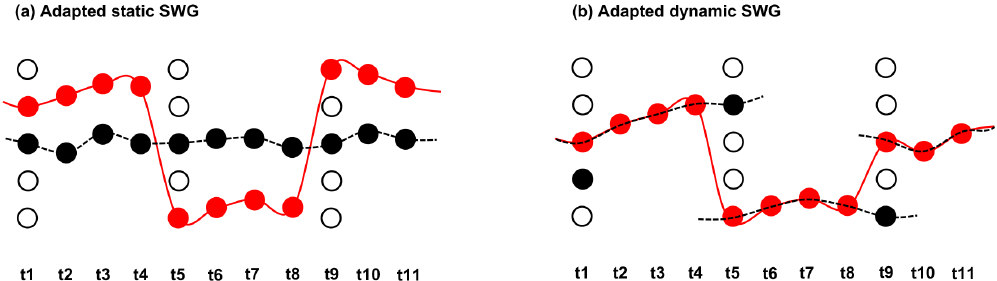
Figure 3. Adapted dynamic weather generators. (a) The adapted static SWG selects a new analogue every n th day (4d in this illustration) and follows the observed trajectory (dotted black line) of that day for 3d. The resulting simulation combines observed 4d chunks into an artificial trajectory (red line). (b) The adapted dynamic SWG replaces the first day of the observations with one of its analogues and follows the observed trajectory of that analogue for 3d. Following this, a new analogue of the following day in the observed trajectory is